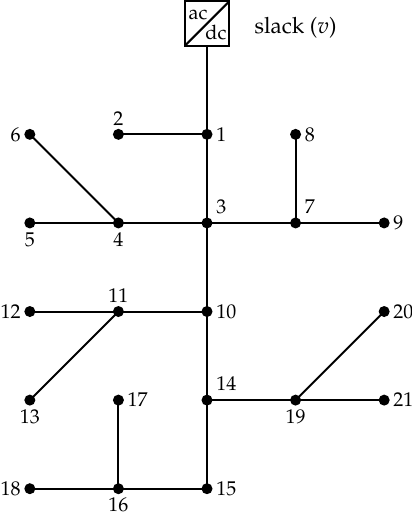
Figure 4. Schematic connection among nodes for the 21-node test